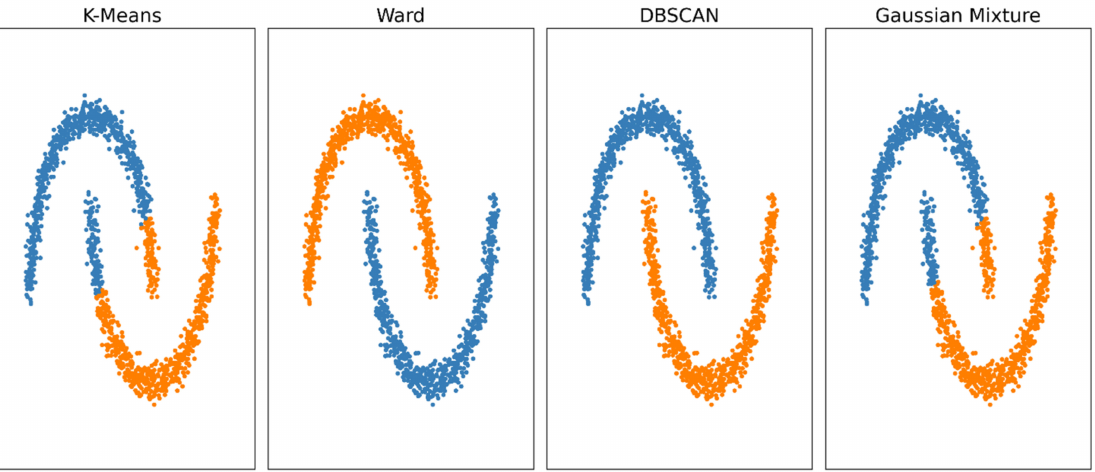
Figure 1. Output of various unsupervised clustering models (k-means, ward, DBSCAN and gaussian mixture) on a 2-feature synthetic dataset with a noisy half-moon morphology for each cluster. The color-coded output depicts the performance of each model in relation to this dataset’s structure, demonstrating how some approaches may be better suited than